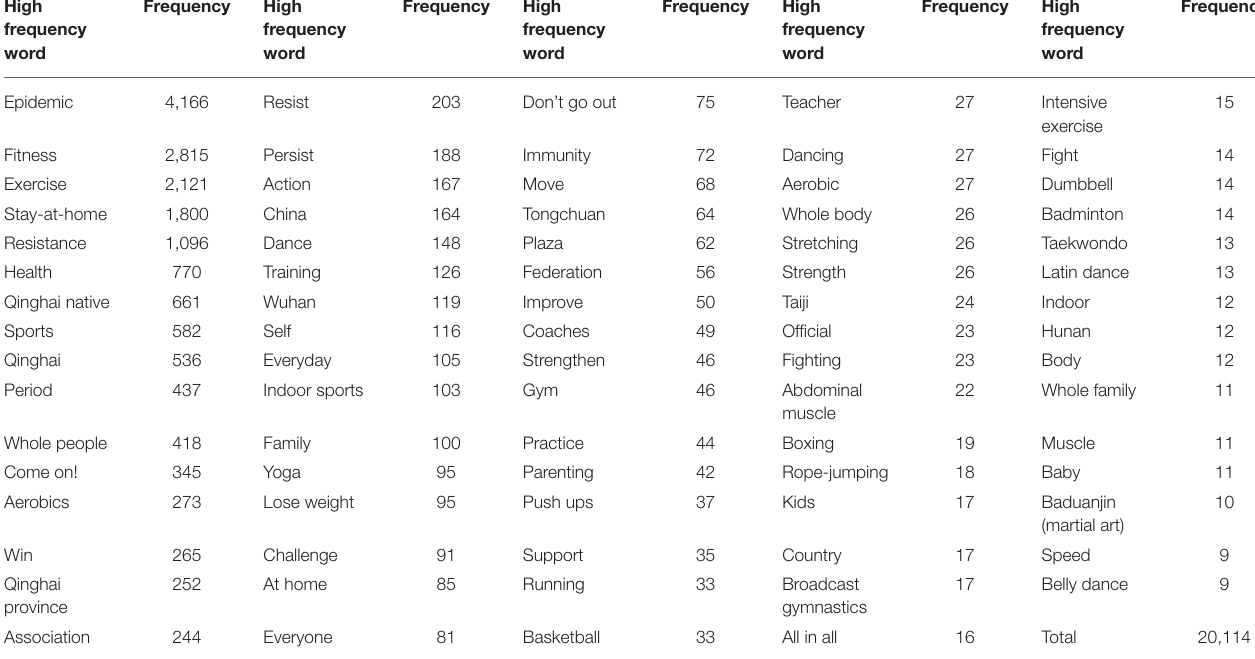
TABLE 4 | High frequency glossary of titles in short fitness videos on TikTok. High frequency